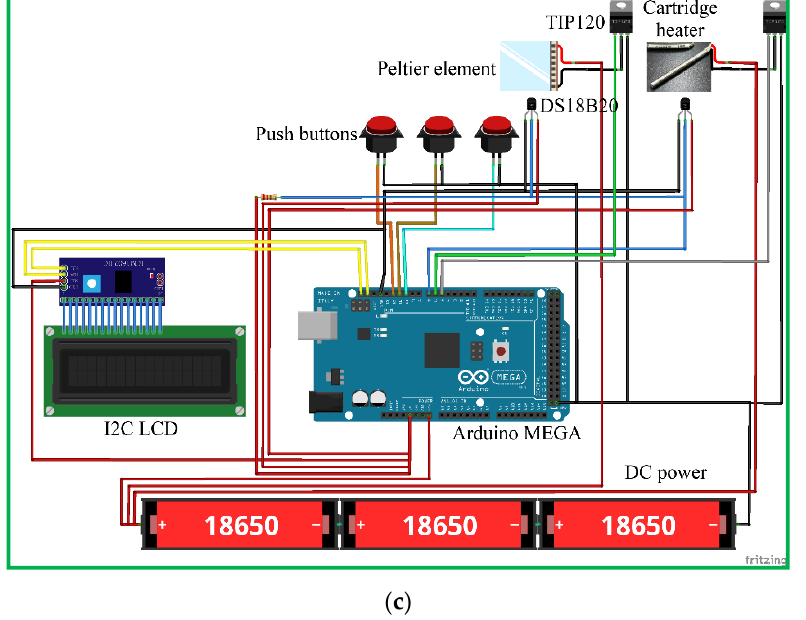
Figure 5. ( a ) A photograph of the thermal control module. ( b ) A schematic diagram of the thermal control functions. ( c ) The five-temperature-region design requires only one half-loop per PCR cycle.